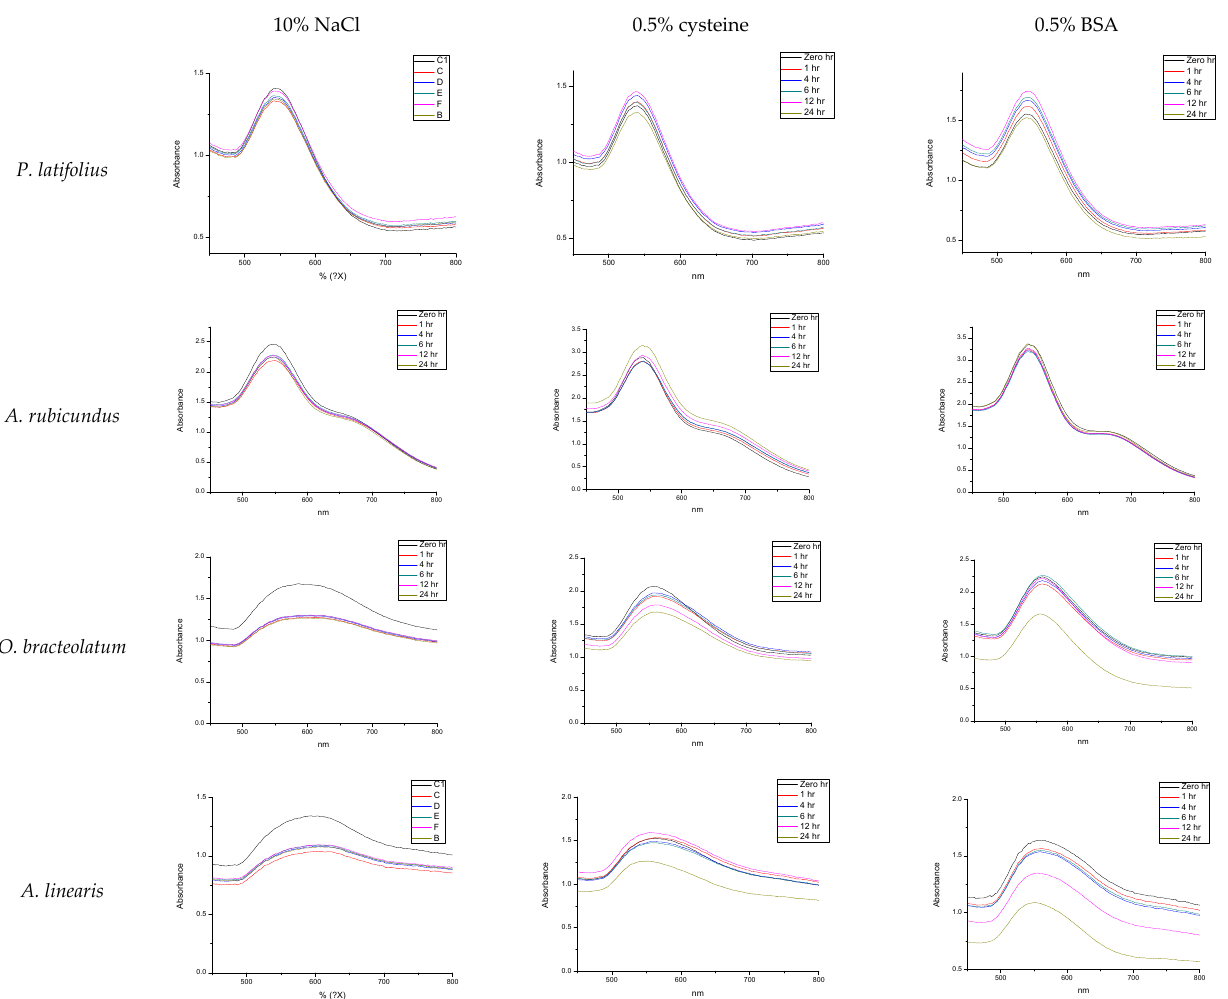
Figure 6. Changes in UV-Vis spectra of AuNPs over a 24-h period in buffers containing 10% NaCl, 0.5% cysteine and 0.5% Bovine Serum Albumin (BSA).